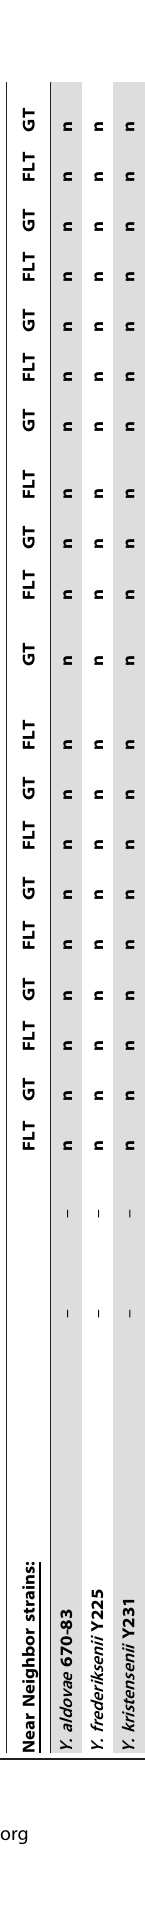
have been observed in the fragment sizing profiles from any of these species. Figure S6A is a representative profile detecting only background noise from all EBS. To further evaluate specificity and sensitivity of the 30-plex assay, target DNAs were spiked with 10 6 copies of EBS. In the presence of this high copy number EBS, the 10-plex signatures of the biothreat agents remained unaffected. Figure S6 (B and C) shows the simultaneous amplification of the 10 Ba loci (100 copies of Sterne) and 10 Yp loci (100 copies of Kim10) from the 30-plex panel in the presence of EBS (10 6 copies of B. cepacia 249). Taken together, these data demonstrate specificity of the designed primers and sensitivity of the 30-plex panel in a large molar excess of background DNA. This data